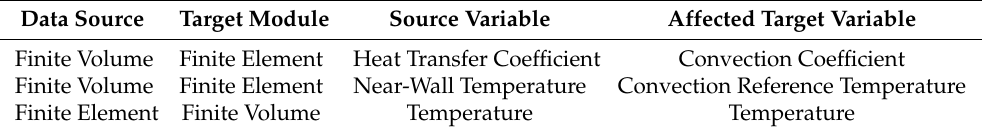
Table 3. Data transfers as set up in two-way fluid–structure interaction